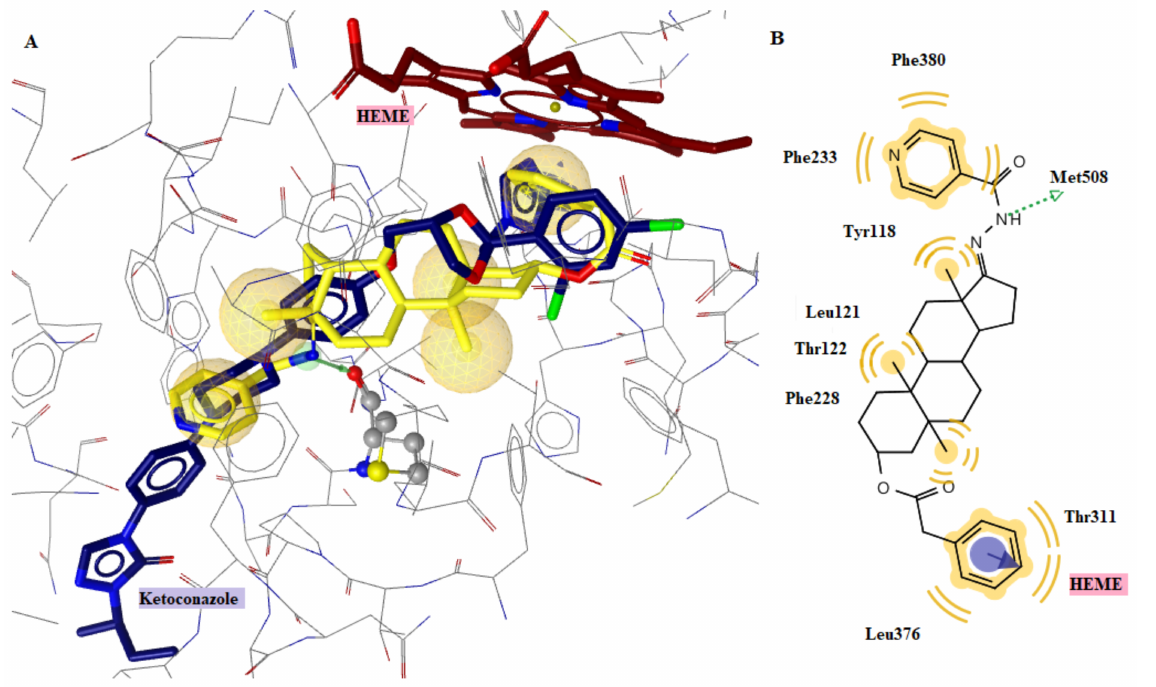
Figure 6. ( A ) Superposition of compound 3 (yellow) and ketoconazole (blue) in lanosterol 14 α - demethylase of C . albicans (CYP51 ca ). ( B ) Docked conformation of compound 3 in lanosterol 14 α - demethylase of C . albicans (CYP51 ca ). Red dotted arrows indicate H-bond, blue arrows aromatic interactions and yellow spheres hydrophobic interactions. Table 4. Drug-likeness predictions of tested